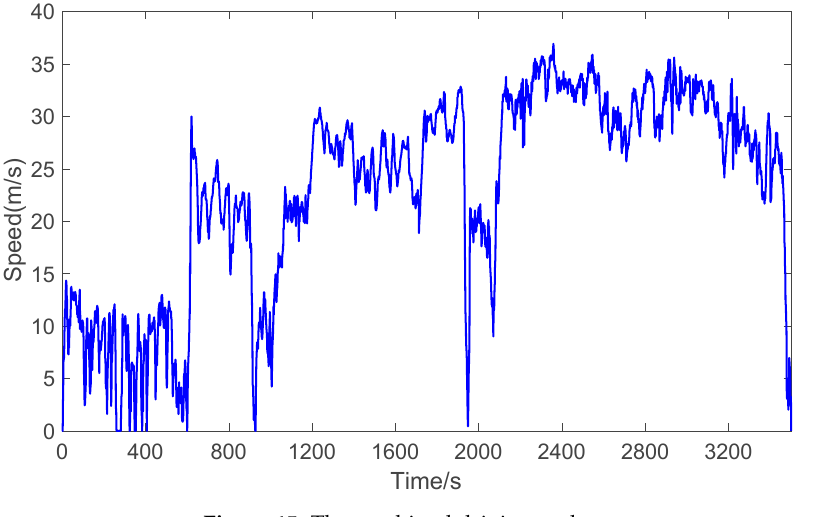
Figure 15. The combined driving cycle. Table 4. The accumulative battery degradation on the tested driving